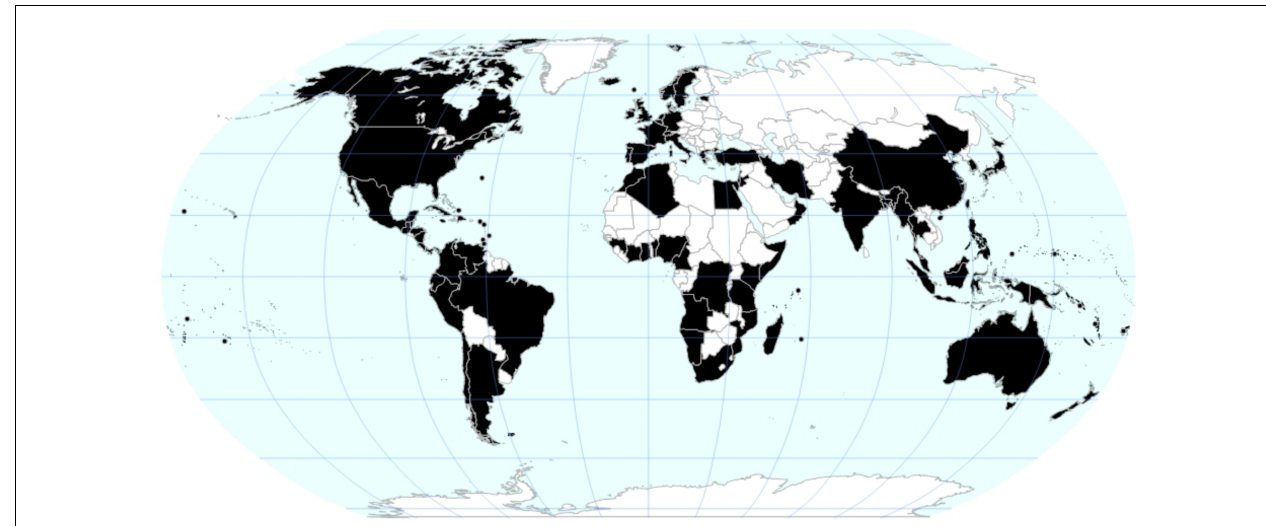
FIGURE 4 | Countries with GOA-ON members as of April 2019 are shaded black, excluding representatives of UN bodies.